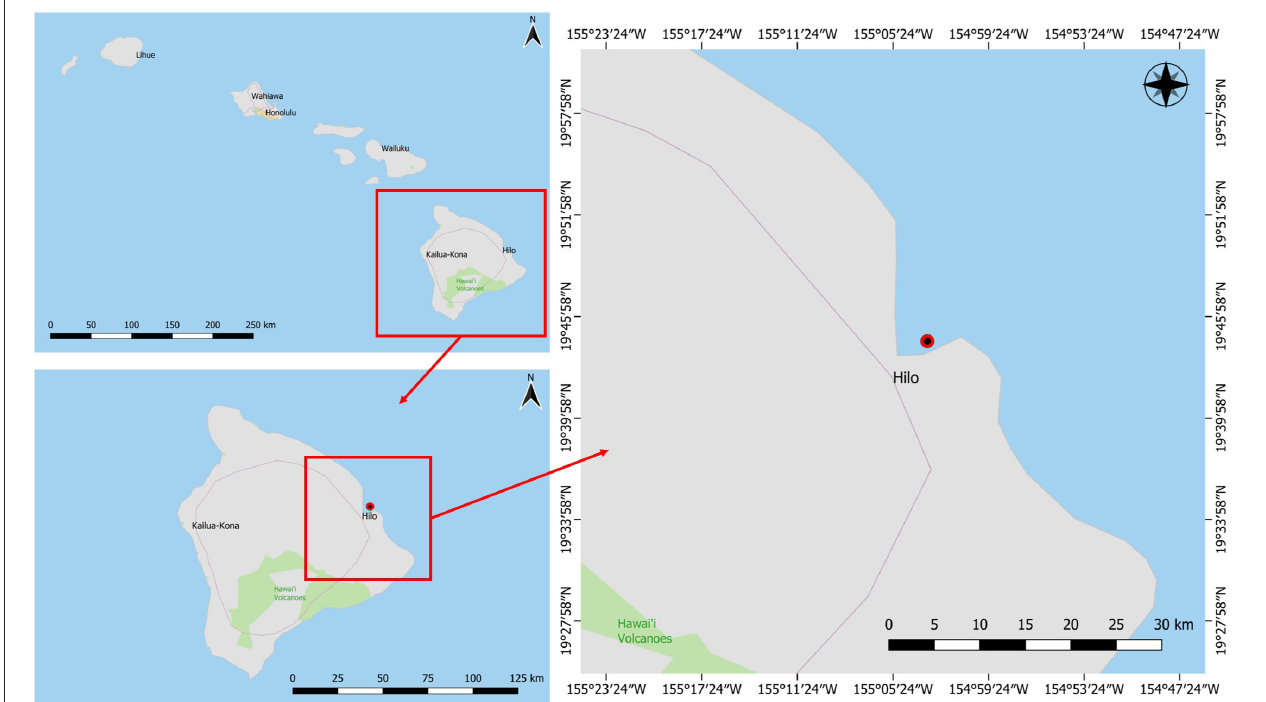
FIGURE 1 | Marine sponge ( Petrosia ) collection site in Puhi Bay on Hawai‘i